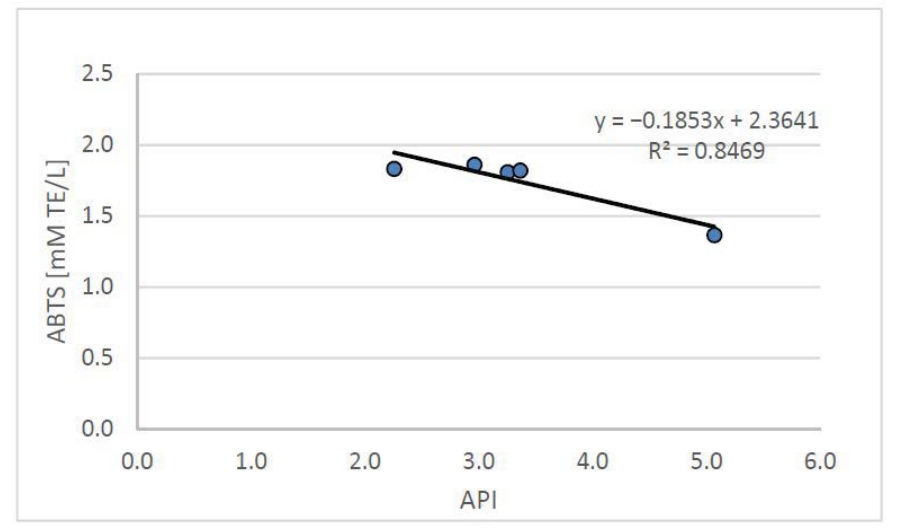
Figure 4. Relation between the API index and plasma antioxidant potential (ABTS) in rats fed control and cholesterol-containing (1% of cholesterol) diet, supplemented with lyophilized vegetables (garlic, white onion, and red onion) during the 28 day experiment. Abbreviations: API—atherogenic index of plasma; ABTS—plasma antioxidant activity measured by ABTS test (ABTS—2,2’-Azino-bis-(3- ethyl-benzothiazoline-6-sulfonic acid) diammonium